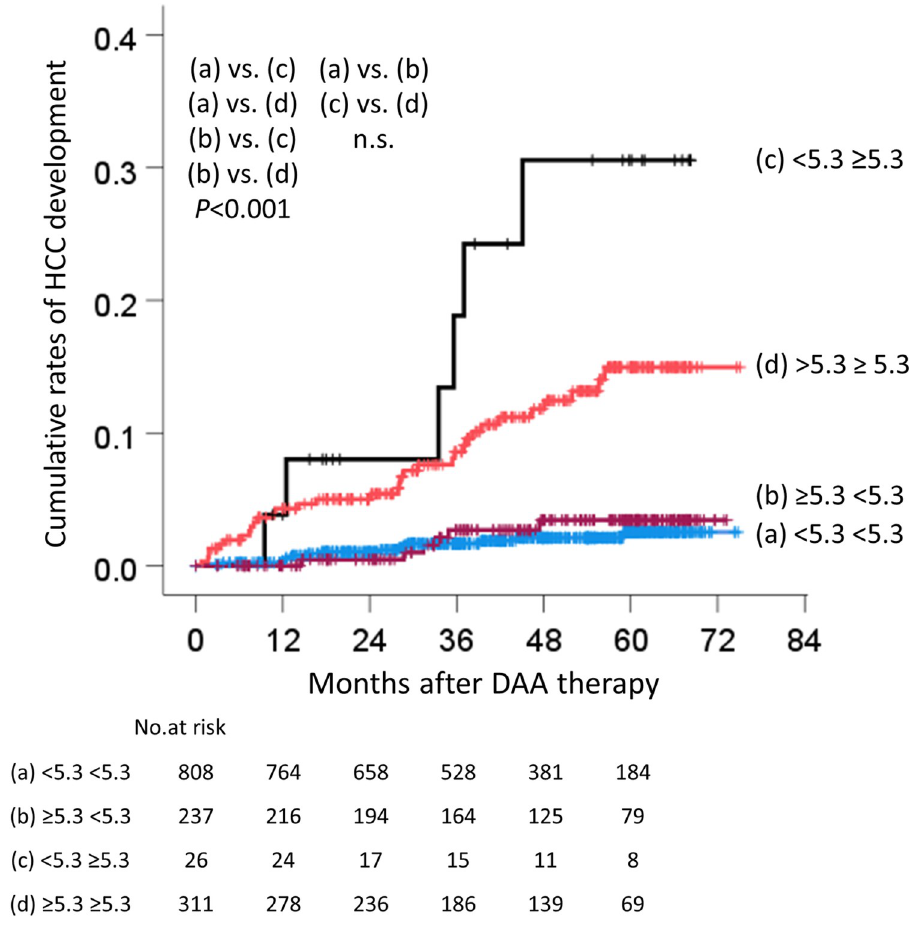
Fig 6. The cumulative rates of HCC development for each change of AFP. AFP was classified into 4 groups before treatment and at the EOT: (a) < 5.3 ng/mL before treatment, and < 5.3 ng/mL at the EOT, (b) � 5.3 ng/mL, < 5.3 ng/ mL, (c) < 5.3 ng/mL, � 5.3 ng/mL, and (d) � 5.3 ng/mL, � 5.3 ng/mL. HCC, hepatocellular carcinoma; DAA, direct- acting antiviral; EOT, end of treatment; AFP, α